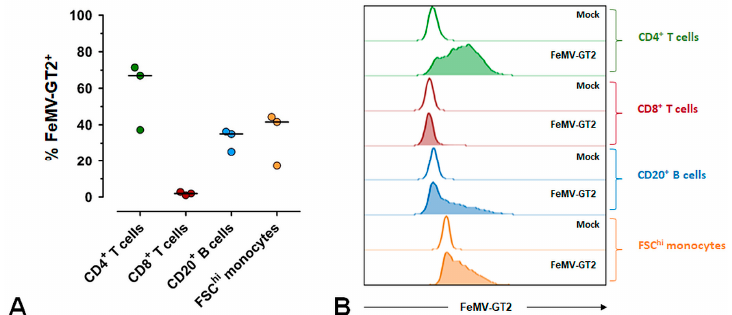
Figure 6. Susceptibility of different blood cell populations to FeMV-GT2. PBMC from healthy cats were infected with FeMV-GT2-Gordon strain (MOI = 0.1) or mock-infected. After 48 hours FeMV-GT2-infected cells among CD4 + T cells, CD8 + T cells, CD20 + B cells and FSC hi monocytes were analyzed by flow cytometry. Only viable cells following doublet exclusion were included in the analysis. Fluorescence-minus-one (FMO) controls were used for appropriate gating of CD4 + T cells, CD8 + T cells and CD20 + B cells. See supplemental Fig. S1 for gating strategy. ( A ) Frequencies of FeMV-GT2-positive cells among CD4 + T cells, CD8 + T cells, CD20 + B cells and FSC hi monocytes of feline peripheral blood are depicted. Gates were set according to the respective mock control. Each dot represents one individual cat, the horizontal bars indicate median values. Data from one representative experiment (three independent experiments were performed) are shown. ( B ) Histograms show representative results of FeMV-GT2-infected PBMC populations in comparison to mock controls.